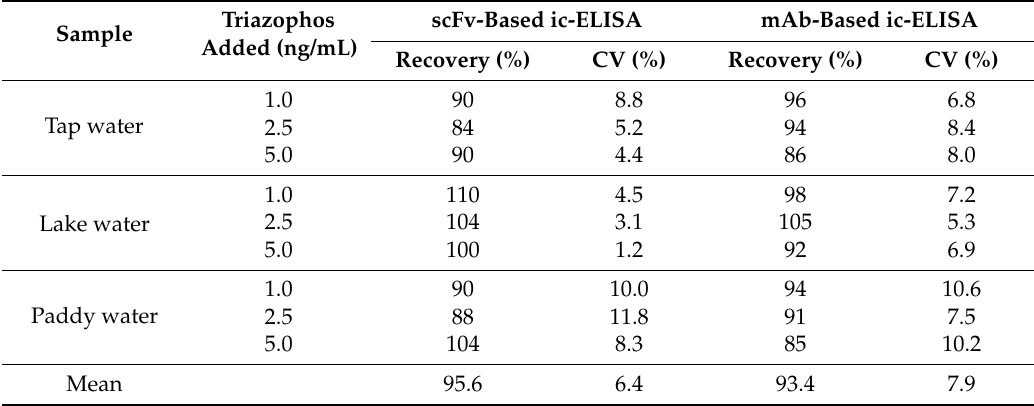
Table 2. Recoveries and precision of triazophos in spiked water samples determined by scFv-based ic-ELISA and mAb-based ic-ELISA ( n =